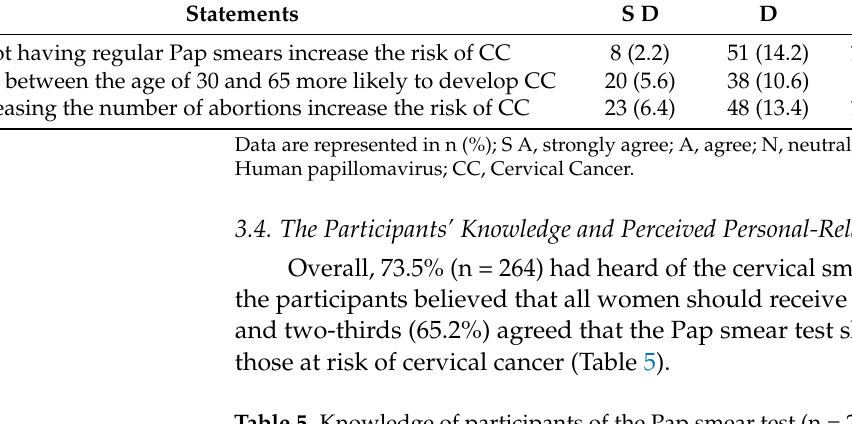
Table 5. Knowledge of participants of the Pap smear test (n =